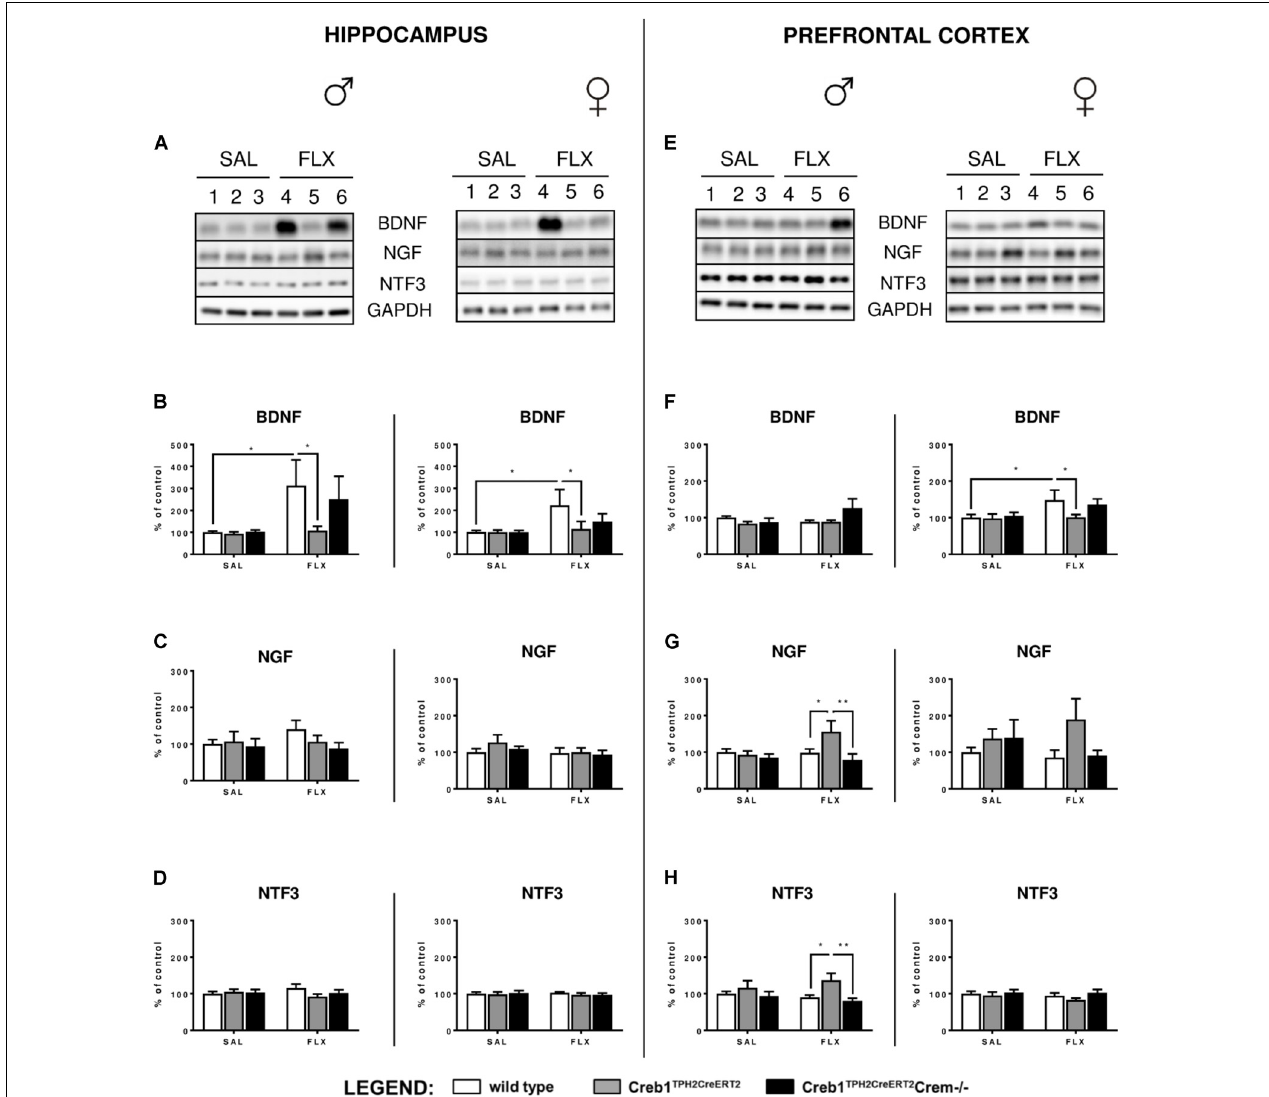
FIGURE 4 | Protein expression of BDNF, NGF, and NTF3 after chronic fluoxetine administration in the hippocampus and PFC of wild-type, Creb1 TPH2CreERT2 and Creb1 TPH2CreERT2 Crem–/– mice. Chronic fluoxetine treatment (10 mg/kg, ip, 1x daily, 21 days) induced BDNF upregulation in the hippocampus of male and female mice (B) and in the PFC of female (F) wild-type animals; the effect was abolished in Creb1 TPH2CreERT2 mice (B,F) . Fluoxetine increased NGF (G) and NTF3 (H) levels in the PFC of male Creb1 TPH2CreERT2 mutants. Western blot analyses of the effects of fluoxetine administration on the protein levels of (B,F) BDNF, (C,G) NGF, and (D,H) NTF3 in the hippocampus (left panel) and the PFC (right panel) of wild-type, Creb1 TPH2CreERT2 , and Creb1 TPH2CreERT2 Crem–/– mice. (A,E) Representative blots of BDNF, NGF, NTF3 and GAPDH in saline (wells 1–3)- and fluoxetine (wells 4–6)-treated wild-type (wells 1, 4), Creb1 TPH2CreERT2 (wells 2, 5) and Creb1 TPH2CreERT2 Crem–/– (wells 3, 6) mice. Data are presented as the mean ± SEM. ∗ p < 0.05, ∗∗ p < 0.01 vs. saline-injected wild-type mice of the same sex. W/t, wild-type; SAL, saline; FLX,